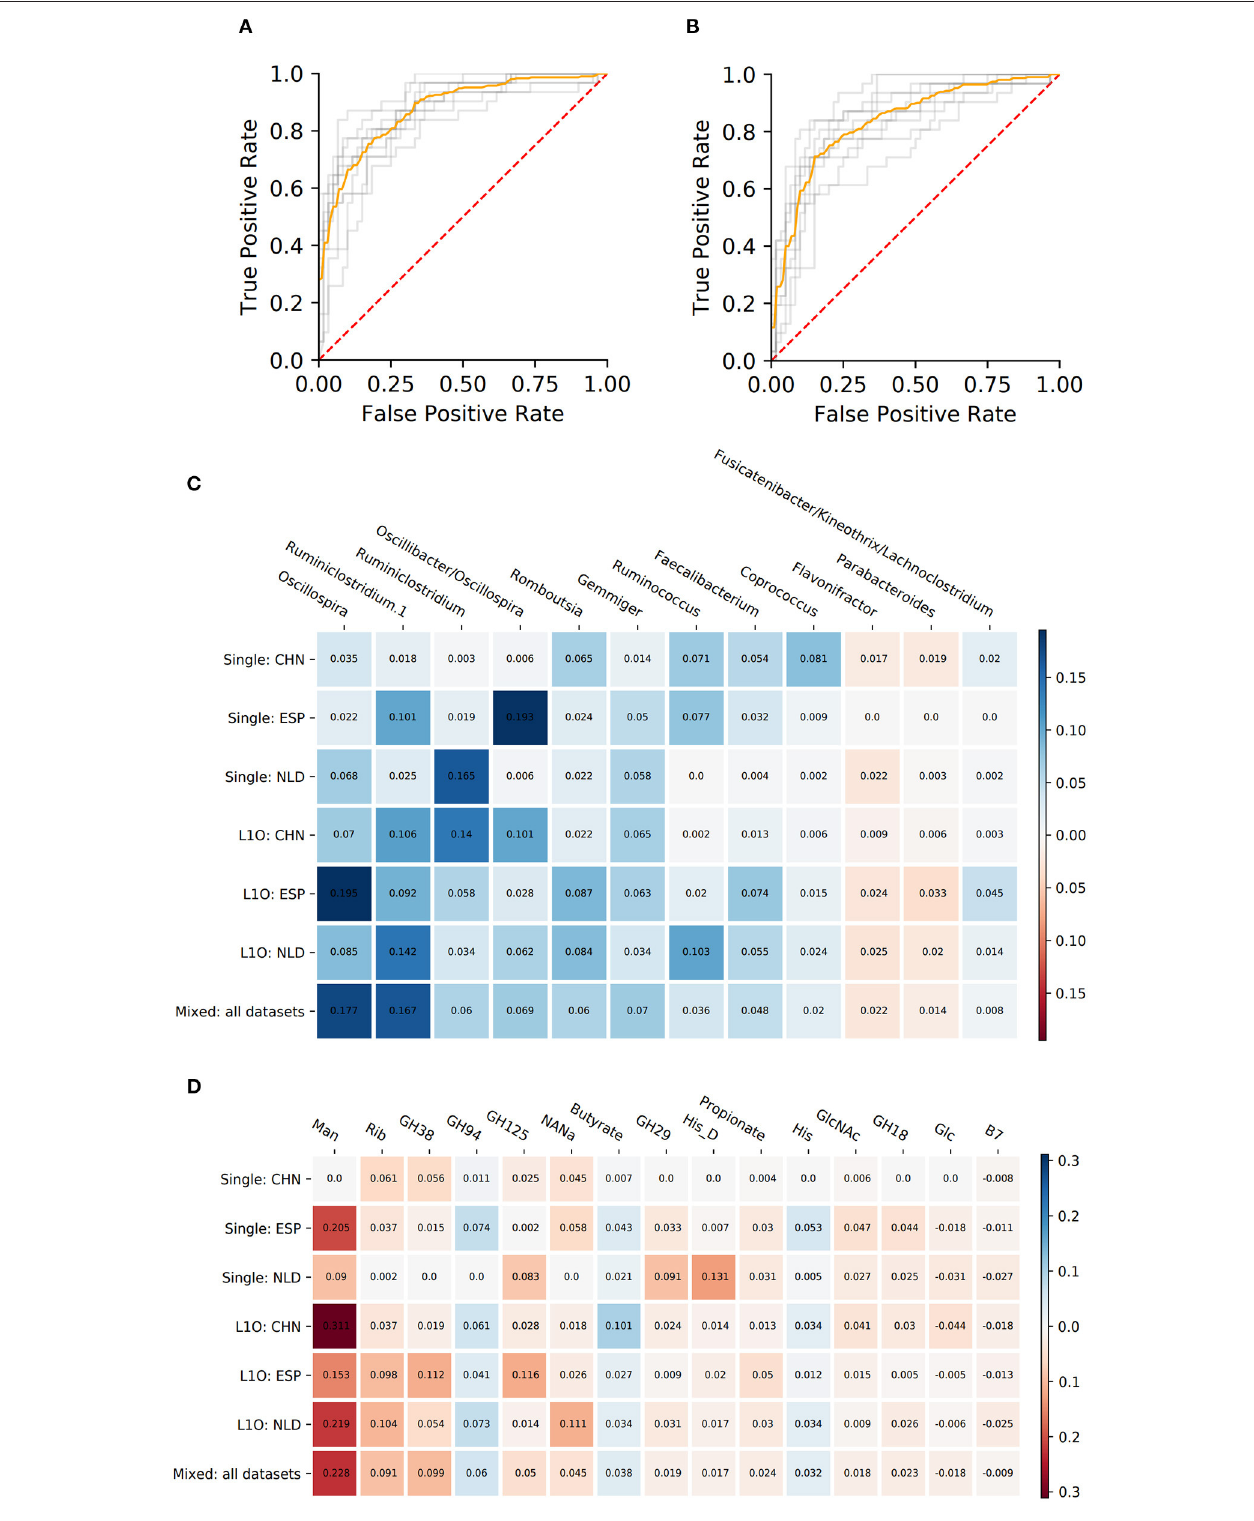
FIGURE 3 | Performance characteristics and stable predictors for the CD-vs.-HC classifier. (A,B) ROC curves for the Mixed strategy for CD-vs.-HC classifiers with taxonomic (A) and phenotypic (B) predictors. (C,D) Stable predictor importance values in different classification variants for taxonomic (C) and phenotypic (D) predictors. Color saturation corresponds to the mean importance of the predictor (see color key). Color hue corresponds to the direction of the difference between HC and CD means (blue—increased in HC, red—increased in CD).